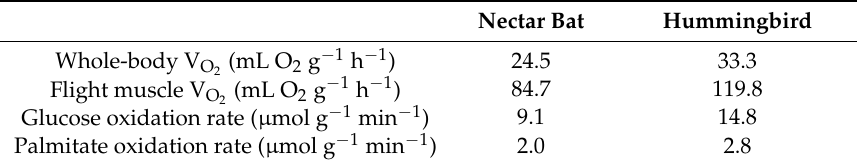
Table 2. Metabolic fluxes in hovering hummingbirds ( Selasphorus rufus ) and nectar bats ( Glossophaga soricina ). Glucose oxidation rates are estimated in animals performing aerial refueling, i.e., hover-feeding when RQ close to 1.0. Palmitate oxidation rates are estimated in animals hovering in the fasted state with RQ close to 0.7. Both glucose and palmitate oxidation rates are easily accommodated by V max values for hexokinase and carnitine palmitoyl transferase, respectively (Table 1). Data from [3]. Nectar Bat